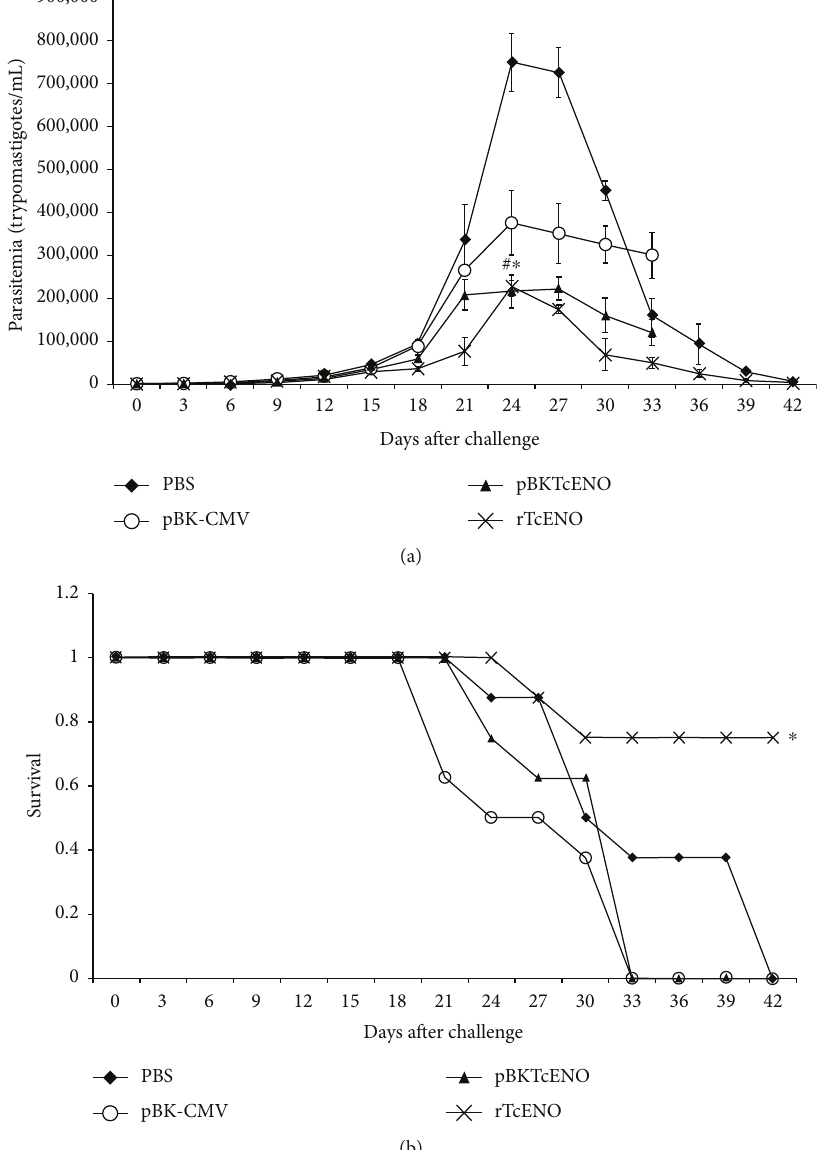
Figure 4: Evaluation of protection generated by vaccination with rTcENO or pBKTcENO. (a) Parasitemia in immunized mice after challenge with T. cruzi . BALB/c mice were immunized as described in Materials and Methods. Values plotted show the mean ± standard deviation of eight mice per group and are representative of two independent experiments. At the peak of infection, parasitemia levels were compared using one-way analysis of variance and post hoc Tukey ’ s tests. A signi fi cant di ff erence was detected by comparing rTcENO versus PBS ( ∗ p < 0 01 ), pBKTcENO versus PBS ( # p < 0 01 ) and pBKTcENO versus pBK-CMV ( ∗ p < 0 01 ). (b) Survival of immunized and infected mice. Values plotted show the mean ± SD of eight mice per group and are representative of two independent experiments with similar results. A statistically signi fi cant di ff erence ( ∗ p < 0 01 ) between rTcENO versus PBS is